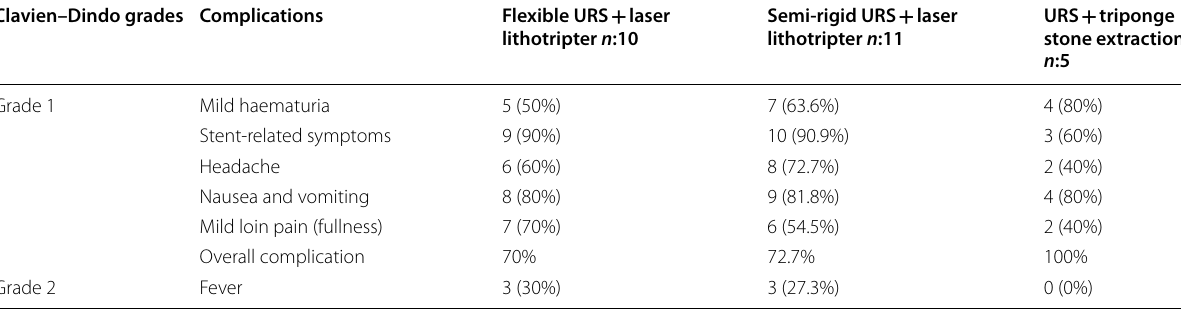
Table 3 Clavien–Dindo grades of the complications in different groups Clavien–Dindo grades Complications Flexible URS